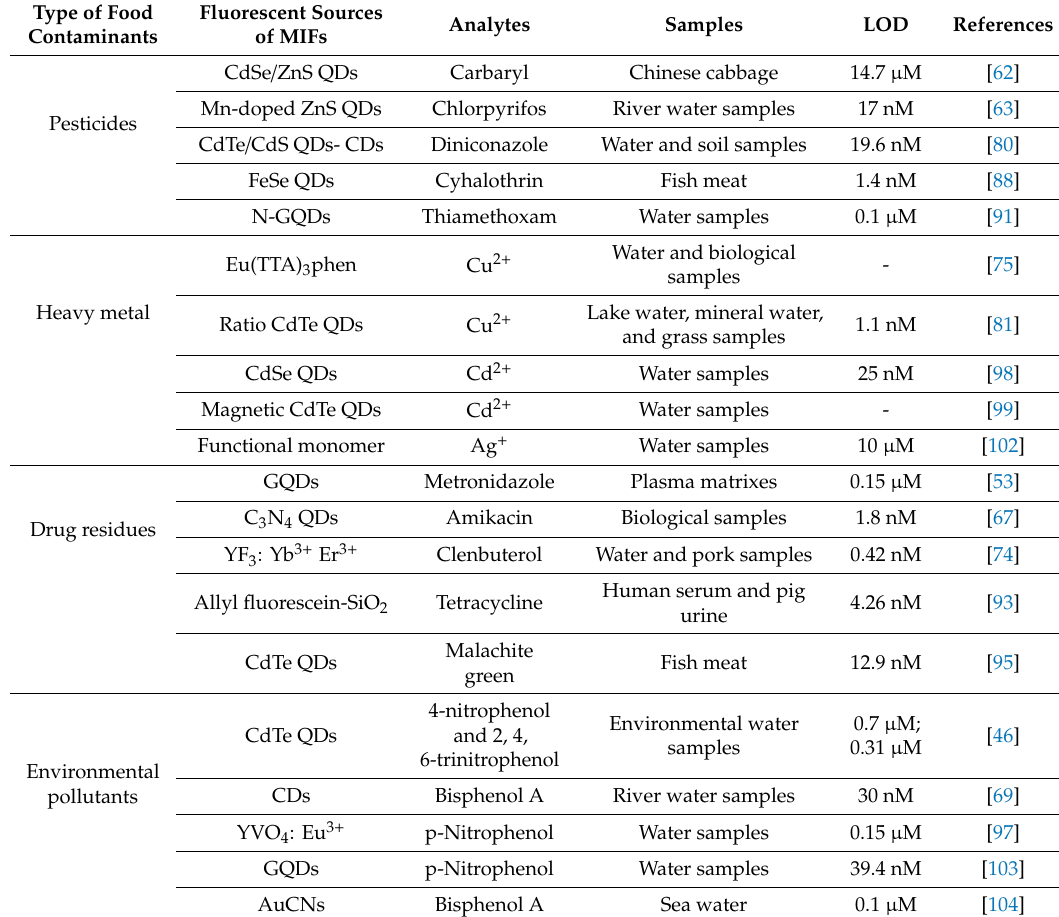
Table 1. The analytical performances of MIFs in determination of pollutants in food and environment